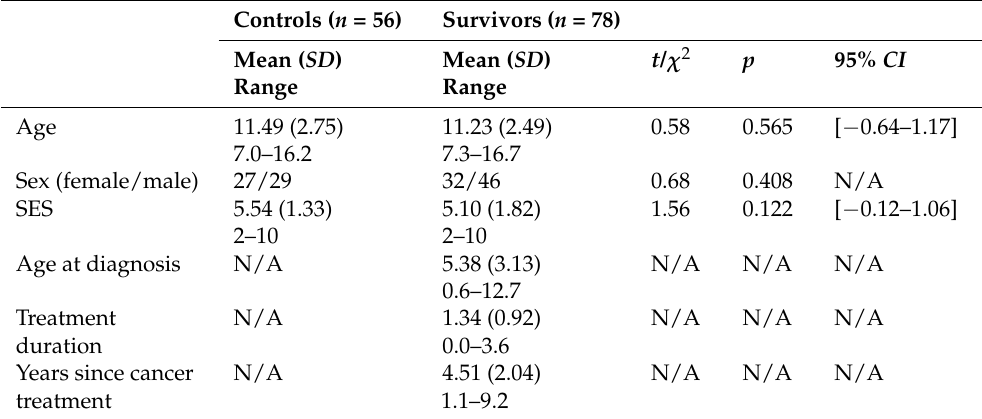
Table 1. Demographic and Clinical